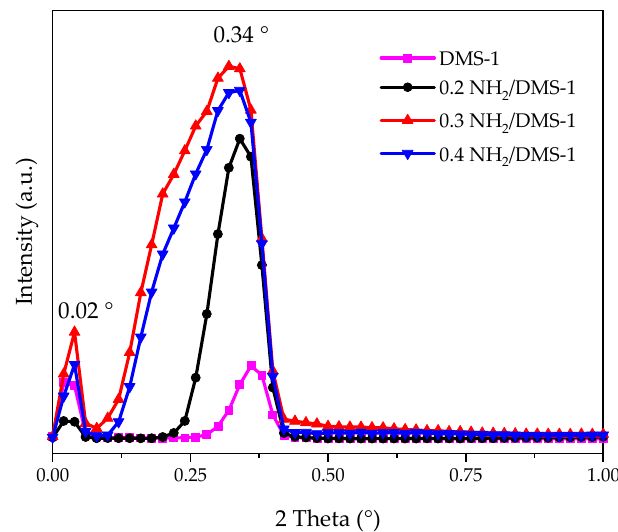
Figure 2. Low-angle XRD patterns of bare DMS-1 and x NH 2 / DMS-1 adsorbents in the range from 0 to 1 ◦ in 2 θ . All samples presented reflections at 0.02 and 0.34 ◦ . Figure 2. Low ‐ angle XRD patterns of bare DMS ‐ 1 and x NH Figure 2. Low ‐ angle XRD patterns of bare DMS ‐ 1 and x NH 2 /DMS ‐ 1 adsorbents in the range from 0 to 2 /DMS ‐ 1 adsorbents in the range from 0 to 1° in 2 θ . All samples presented reflections at 0.02 and 0.34°. 1° in 2 θ . All samples presented reflections at 0.02 and 0.34°.